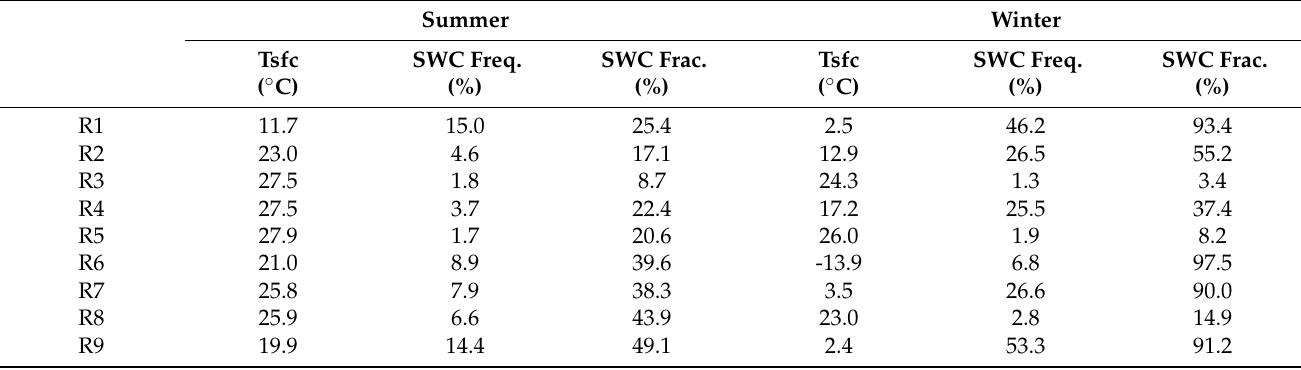
Figure 8. Same as Figure 7 except for the 3-year boreal winter. Table 2. Seasonal mean near-surface air temperatures (Tsfc), total frequencies of supercooled water clouds (SWC Freq.), and fractions of supercooled water clouds out of all water clouds (SWC Frac.) for the nine regions of interest in the 3-year boreal summer and winter.